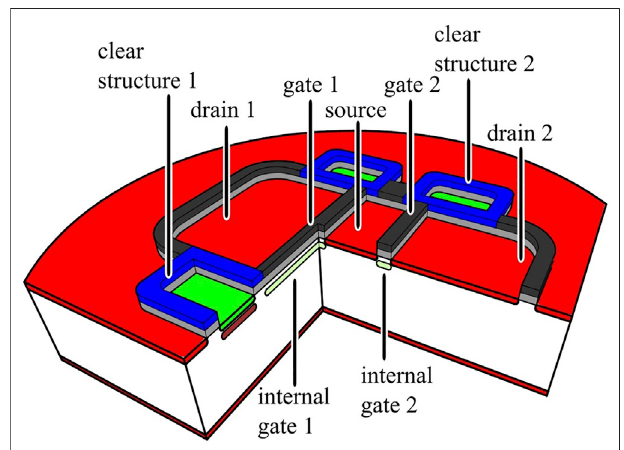
FIGURE 9 | shows an In fi nipix. It is formed by placing two linear DePFETs close to each other. The devices share the source contact and always one DePFET is collecting charge while the other is insensitive and ready for readout. The selection, which DePFET collects charge is done via the potentials applied to the devices drains